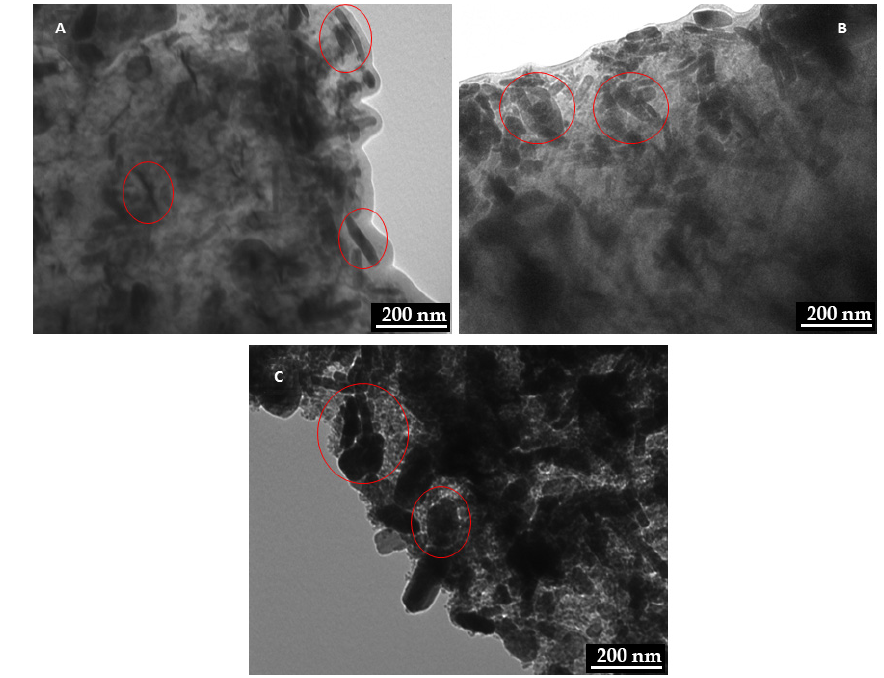
Figure 9. TEM micrographs of the samples after different heat treatments: quenched and tempered at 590 °C for 6 h ( A ), quenched and tempered at 590 °C for 10 h ( B ), quenched and tempered at 590 °C 6 h + 590 °C 4 h ( C ).